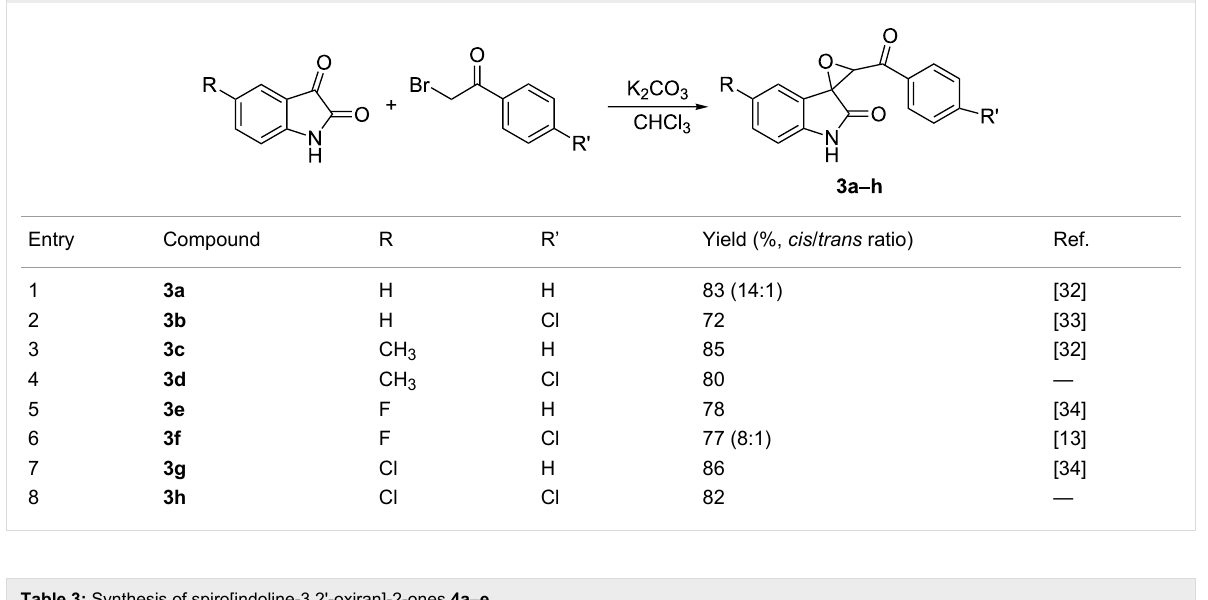
Table 3: Synthesis of spiro[indoline-3,2'-oxiran]-2-ones 4a – e